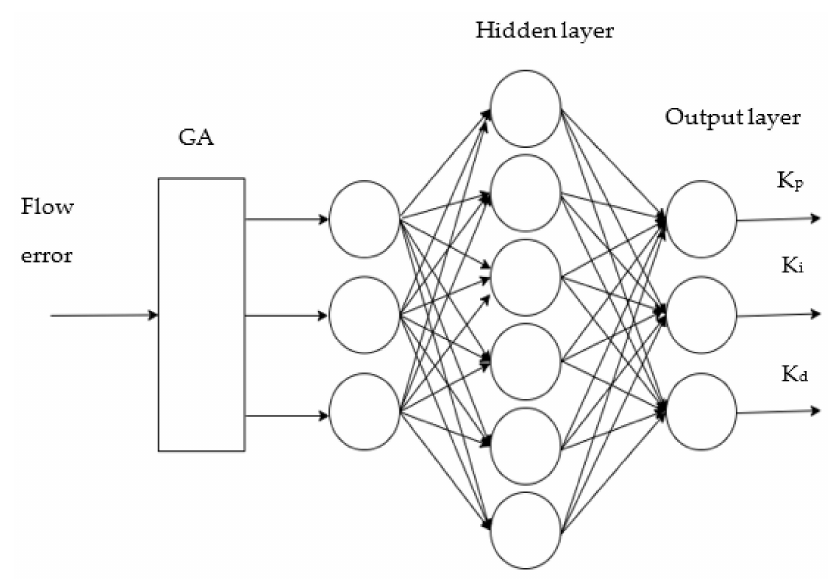
Figure 8. GA–BPNN–PID structure